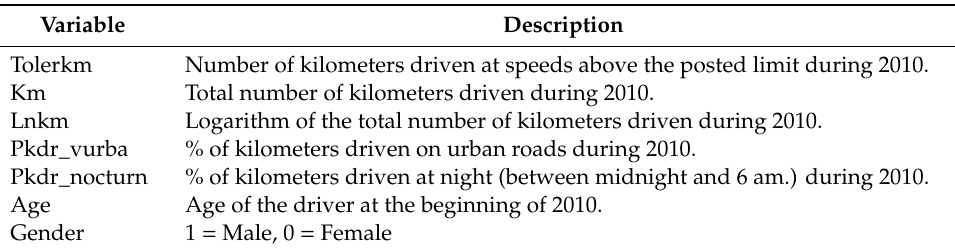
Table 1. Variable description.